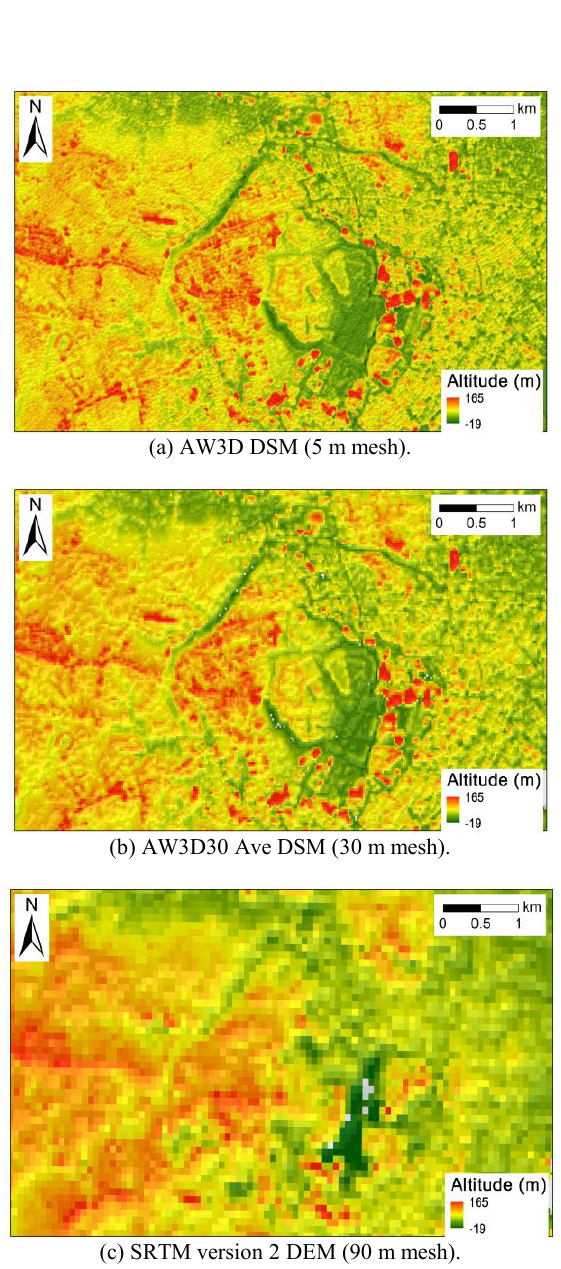
Figure 5. Comparison among (a) AW3D DSM (5m mesh), (b) AW3D30 Ave DSM (30m mesh), and (c) SRTM version